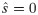
Comparing different dynamical measures, and the effect of system size.The columns correspond to the quantities fλ>0 (left), Tav (middle) and ρrms (right), as defined in the methods section. The rows from top to bottom correspond to increasing system sizes, characterized by the number of neurons N in the neural networks. For each of the 12 cases, a two-dimensional phase diagram is shown as a function of balance and density, keeping a constant symmetry parameter of s^=0. The three dynamic phases become apparent only for systems with a minimum size of N ≥ 100. The three different dynamical measures are mutually consistent. In particular, the chaotic regime is characterized by a fλ>0 close to one, by a diverging Tav, and by a vanishing ρrms. For large systems with N ≥ 10000, the density parameter has no more effect on the system dynamics, which is then controlled by the balance only.